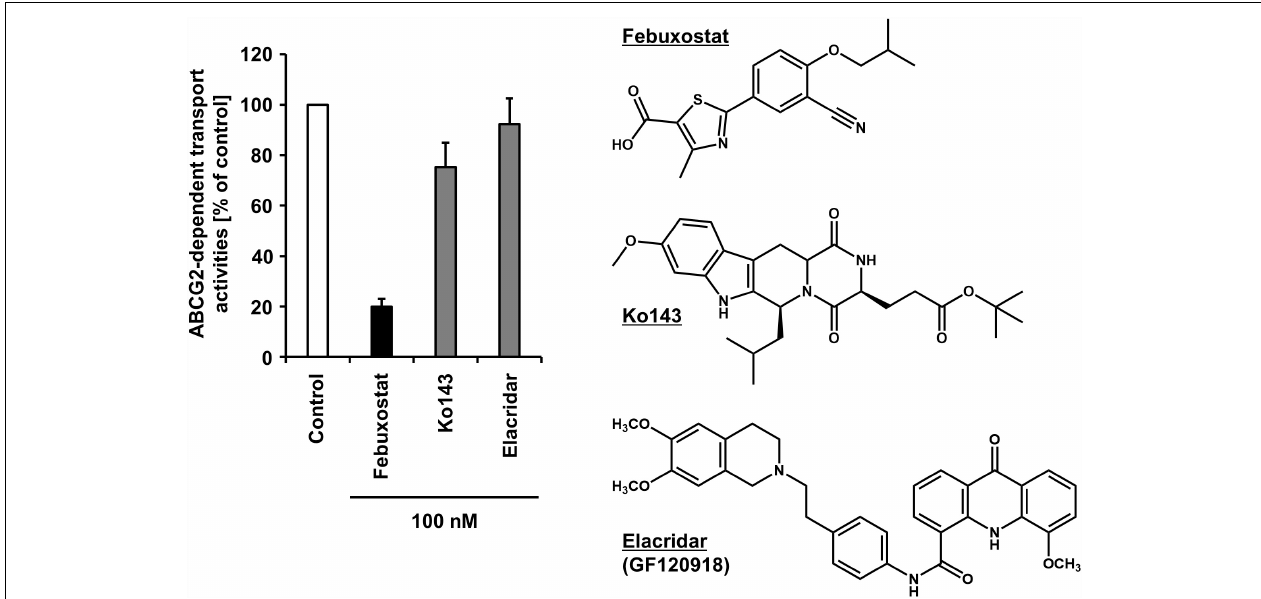
FIGURE 2 | Inhibitory effect of febuxostat against ABCG2 is stronger than that of Ko143 and elacridar, two well-used ABCG2 inhibitors. Febuxostat is known as an oral hypouricemic agent inhibiting xanthine oxidoreductase, a key enzyme for uric acid production. (Left) Effect of each compound on the transport activity of ABCG2 are shown. Data from our previous study under CC BY license (Miyata et al., 2016) are shown graphically, in which in the absence (vehicle control) or presence of 100 nM of each compound, the ATP-dependent urate transport activities of ABCG2 were measured using the vesicle transport assay. Data are expressed as the mean ± SD, n = 3. Of note, the half-maximal inhibitory concentration (IC 50 ) of febuxostat against the urate transport activity of ABCG2 was 27 nM in the previous study. (Right) Chemical structures of each compound are